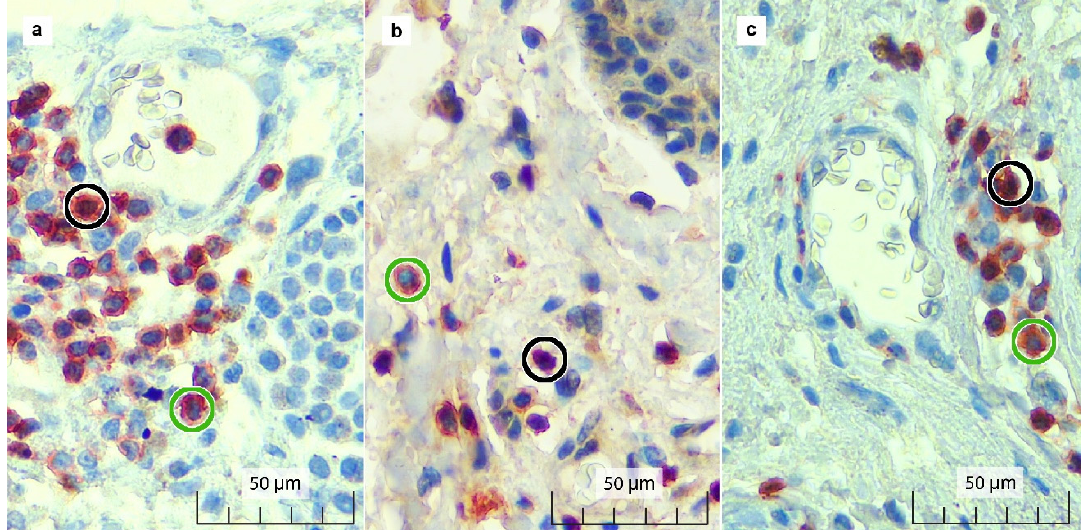
Figure 2. Double immunostaining results for FOXP3 and CD3 in the ( a ) TC, ( b ) TP, and ( c ) NAT. FOXP3+/CD3+ (double-positive) Treg cells show brown-stained nuclei surrounded by red-stained cell membranes (black circle). CD3+ (single-positive) sTILs show red-stained cell membranes with unstained blue nuclei (green circle).